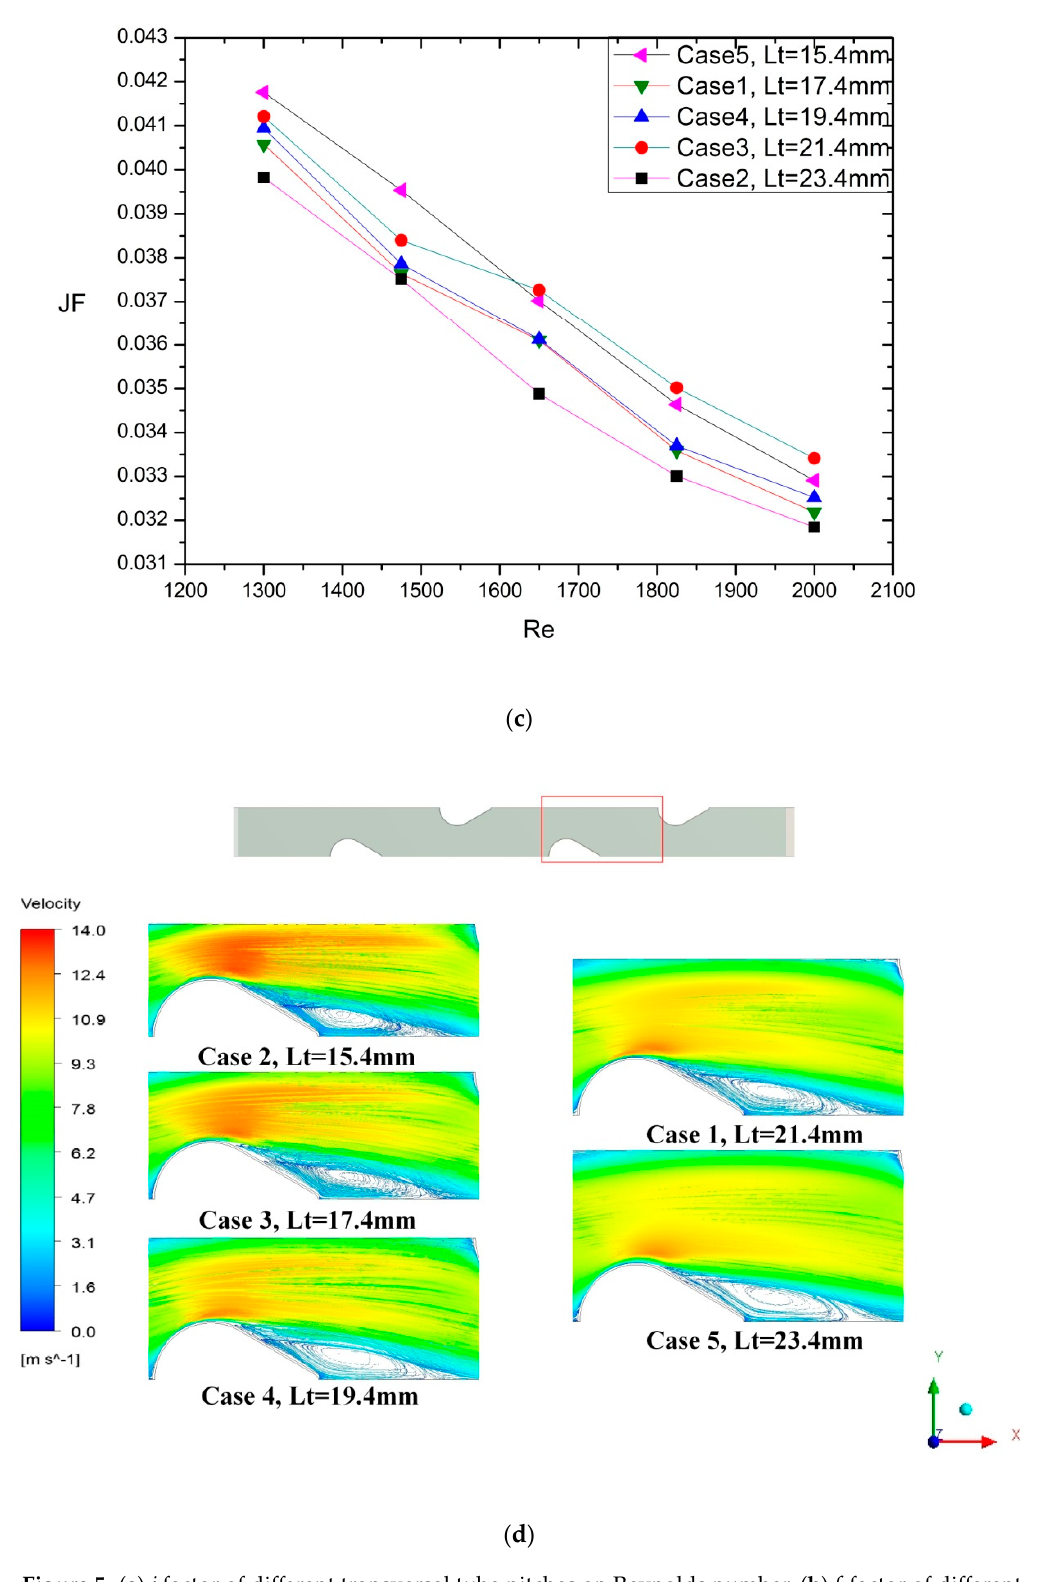
Figure 5. ( a ) j factor of different transversal tube pitches on Reynolds number, ( b ) f factor of different transversal tube pitch on Reynolds number, ( c ) JF factor of different transversal tube pitch on Reynolds number, ( d ) The flow field of different transversal tube pitch.